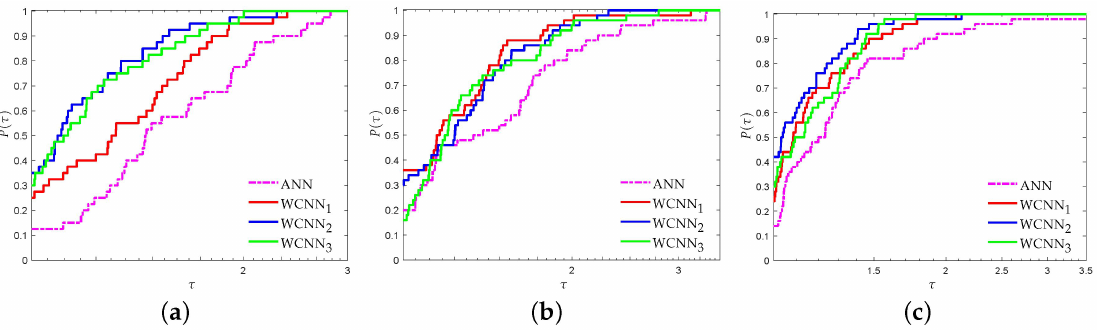
Figure 7. Performance profiles based on MAE for foreign tourists arrivals (log 10 scaled). ( a ) Forecasting horizon = 6; ( b ) Forecasting horizon = 9; ( c ) Forecasting horizon =